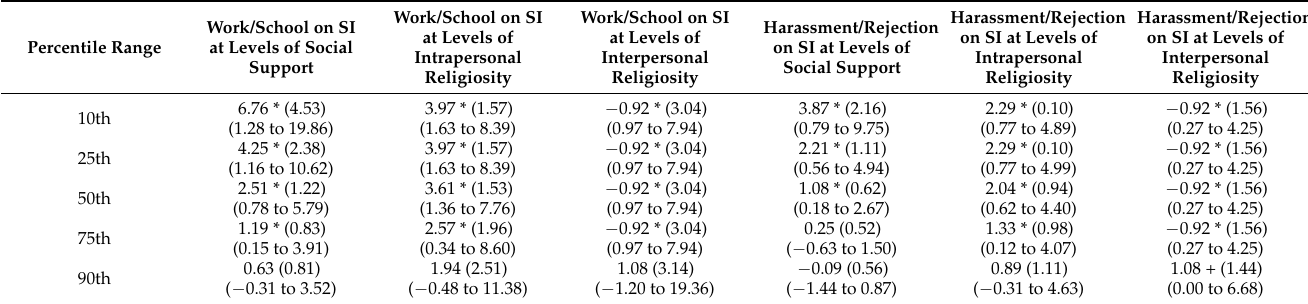
Table 3. Conditional Indirect Effects, Estimate SE, and 95% Bias-corrected Bootstrap Confidence Interval ( N = 99).